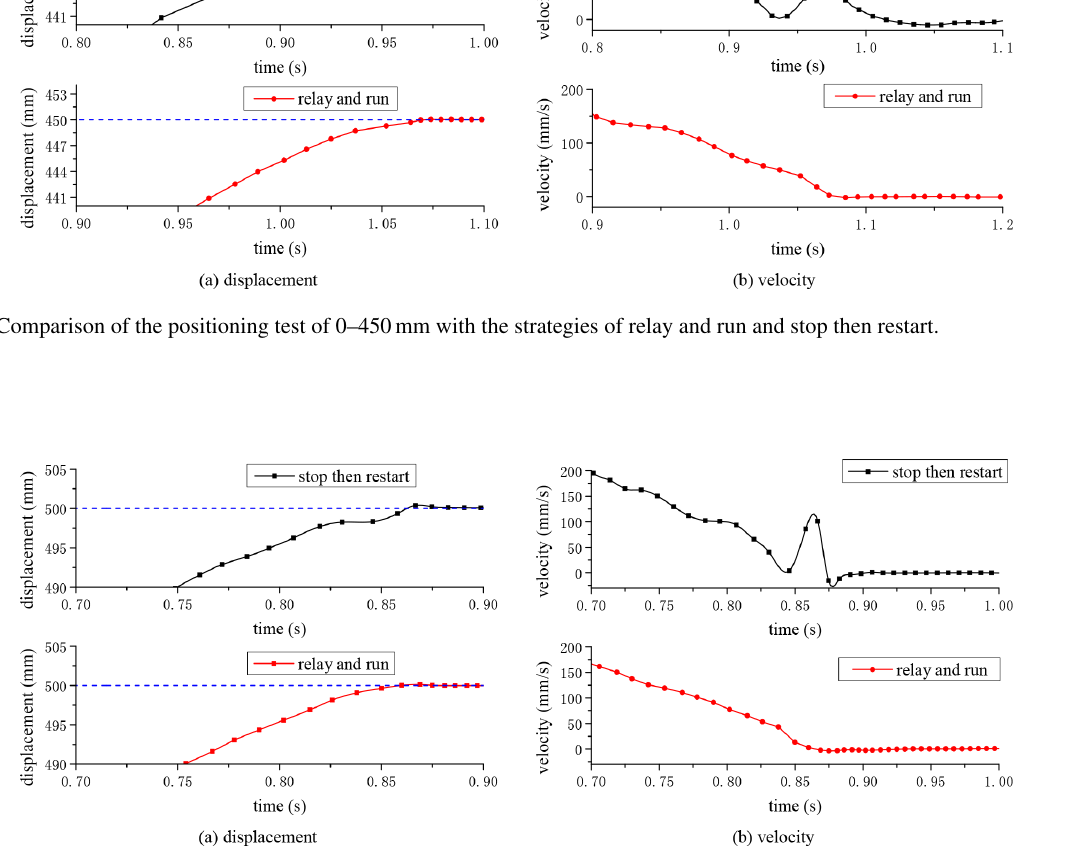
Mech. Sci., 12, 971–982,